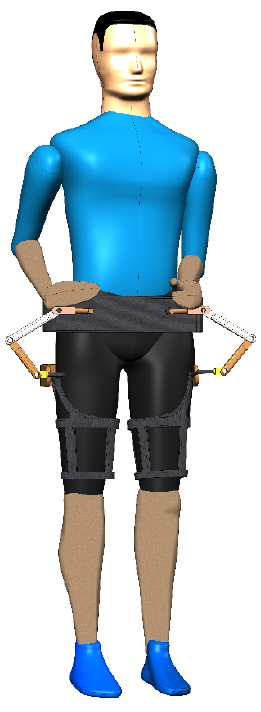
Figure 5. Wearable hip joint mechanism.